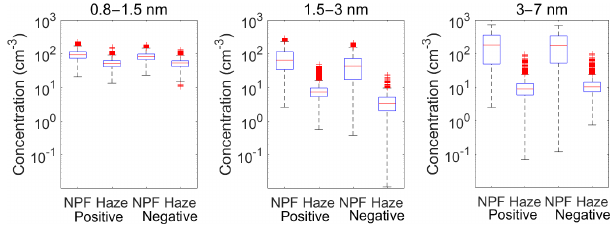
Figure 13. Positive and negative ion number concentrations in the size bins of 0.8–1.5, 1.5–3 and 3–7nm on the NPF event days and the haze days separately. The whiskers include 99.3% of data of ev- ery group. Data out of 1.5 times the interquartile range are located outside of the whiskers and considered outliers. The lines in the boxes represent the median value, the lower part of the boxes rep- resents 25% of the number concentration, and the upper part of the boxes represents 75% of the number concentration. Data marked with red plus symbols represent